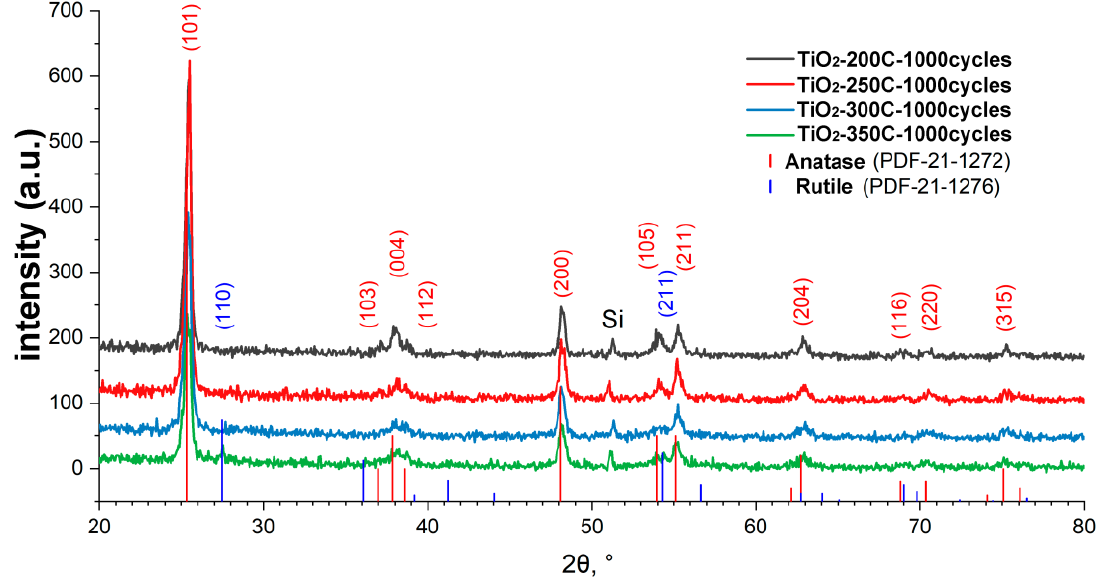
Figure 3. XRD patterns of titanium oxide samples obtained using TiCl 4 for 1000 ALD cycles on the silicon surface.